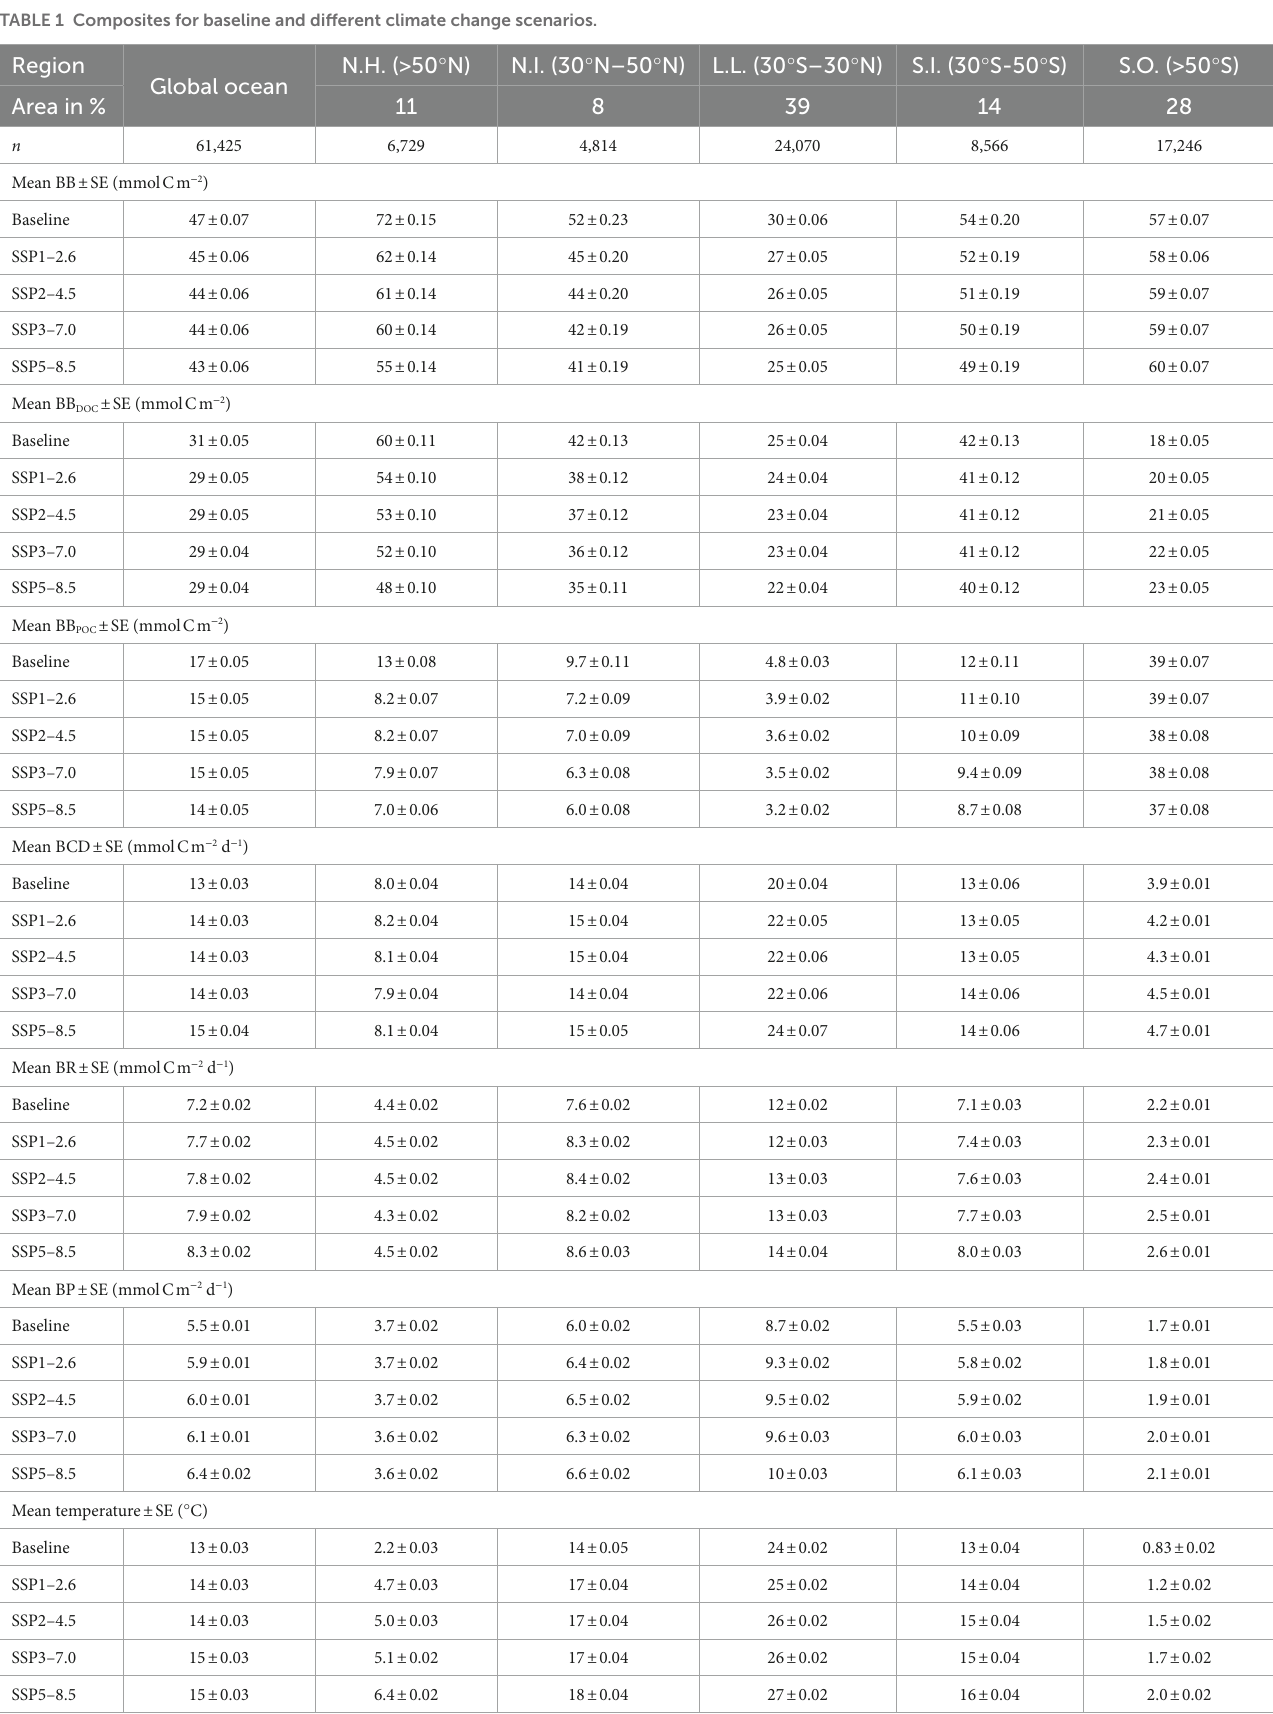
TABLE 1 Composites for baseline and different climate change